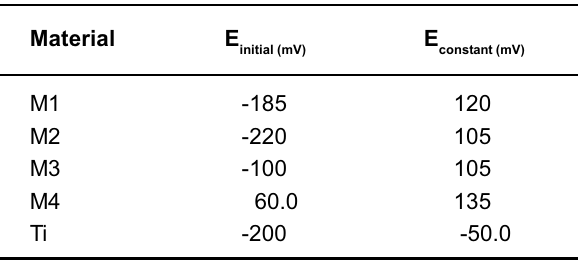
TABLE 2- Open-circuit potentials data for Ti and the suprastructures